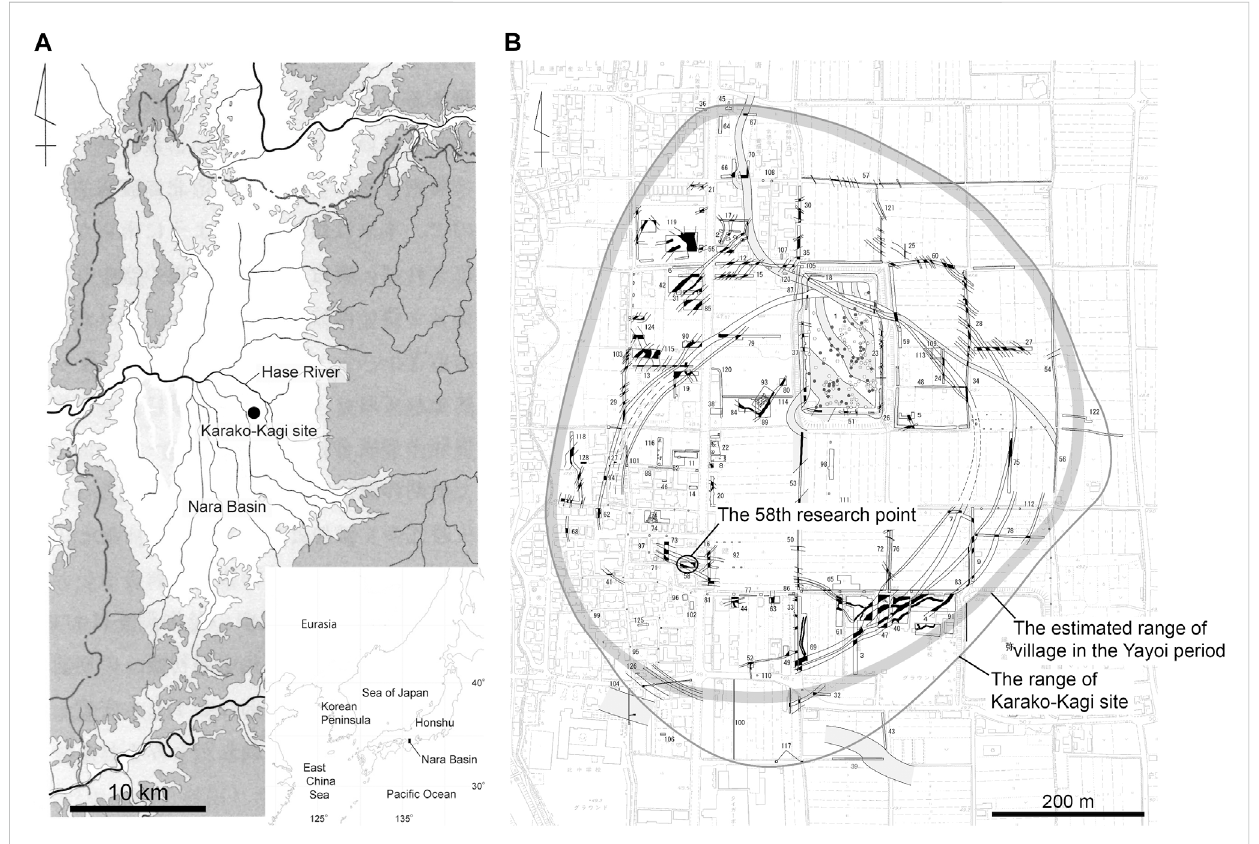
FIGURE 1 Location of the Karako-Kagi site (A) and its 58th research point (B) .